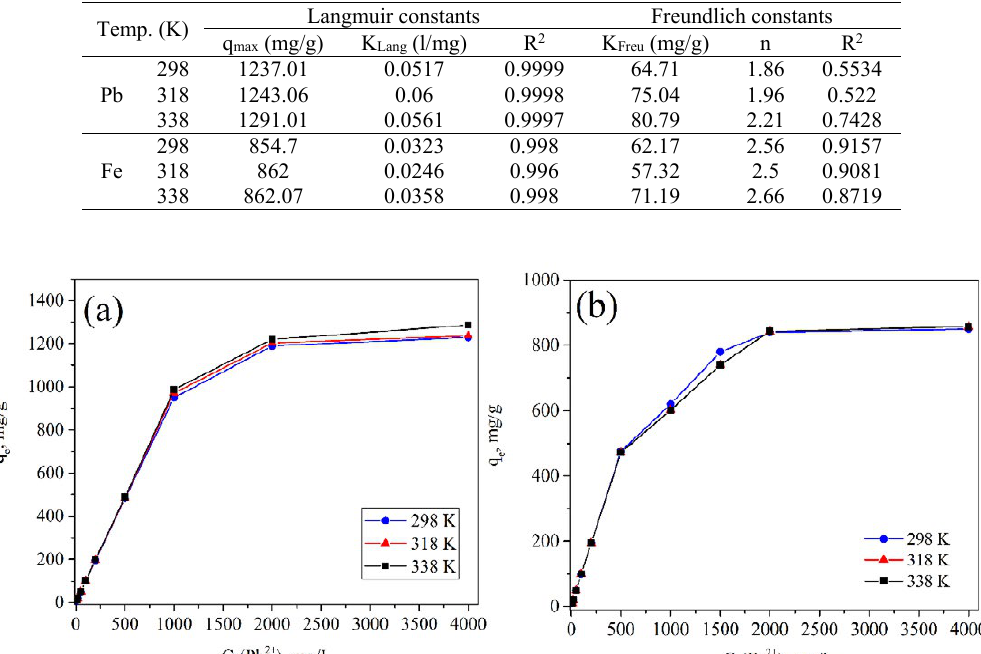
Fig. 4: Adsorption isotherms of CaCO nanoparticles for (a) Pb 2+ and (b) Fe 2+ at different temperatures. 3 Fig. 4. Adsorption isotherms of CaCO 3 nanoparticles for (a) Pb 2+ and (b) Fe 2+ at different temperatures.